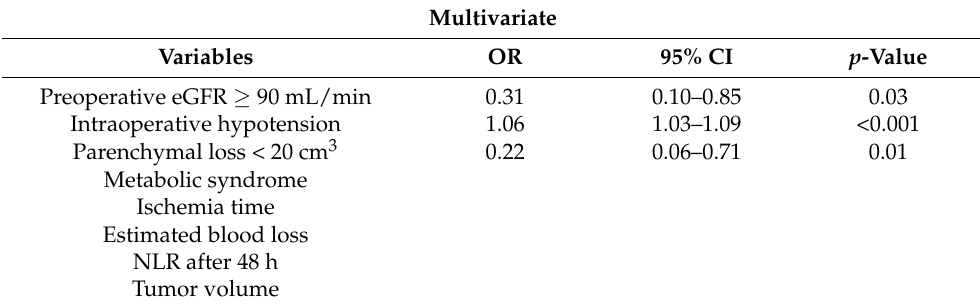
Table 4. Factors predicting clinically significant postoperative acute kidney injury.